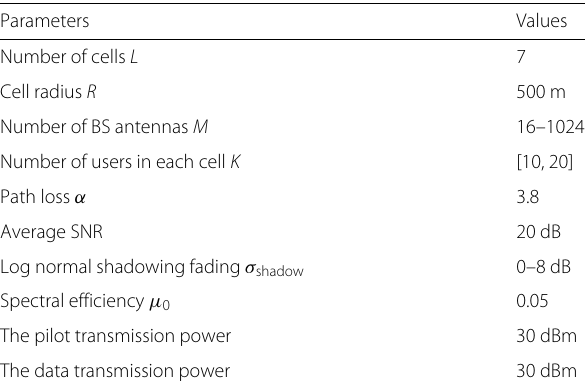
Table 2 Basic parameters of system simulation Parameters